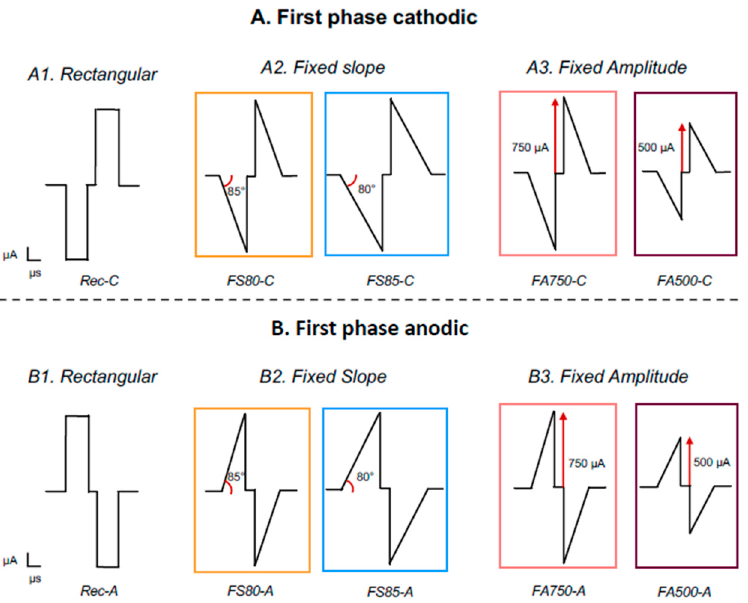
Figure 1. Schematic diagram representing the different pulse shapes used in this study. ( A ) Rectan- gular and four ramped pulses with either a fixed slope (of 85° and 80°) or a fixed peak amplitude (of 750 and 500 µA) with a cathodic-first phase. ( B ) Same pulse shapes with the anodic-first phase. The color code surrounding each ramped pulse shape will be used for the subsequent